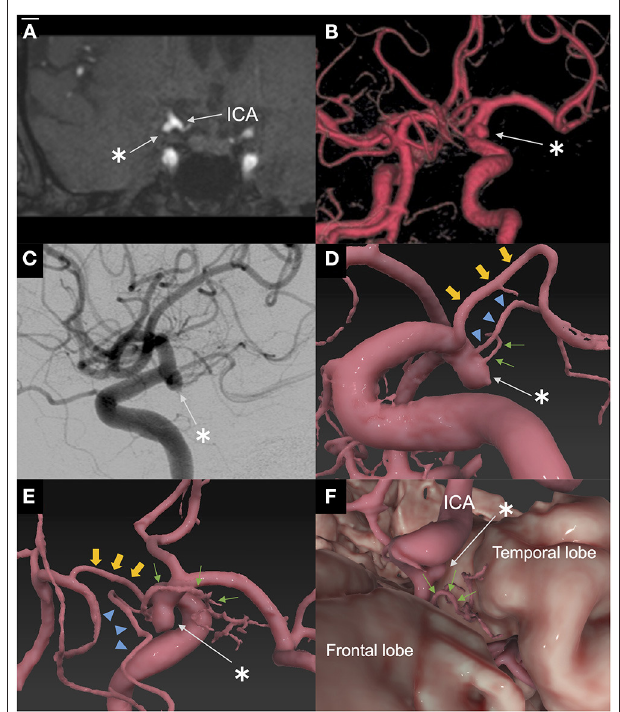
FIGURE 1 | Preoperative imaging. (A) Coronal plane of time-of-flight magnetic resonance angiography on admission. Coronal plane of time-of-flight magnetic resonance angiography showed an unruptured aneurysm of the right internal carotid artery in contact with the temporal lobe. *: aneurysm. (B) Three-dimensional time-of-flight magnetic resonance angiography on admission. Three-dimensional time-of-flight magnetic resonance angiography showed an unruptured aneurysm of the right internal carotid artery supraclinoid portion. *: aneurysm. (C) Lateral view of digital subtraction angiography of the right internal carotid artery. Lateral view of digital subtraction angiography of the right internal carotid artery showing an aneurysm associated with a duplicated middle cerebral artery and anterior choroidal artery. *: aneurysm. (D) Fusion three-dimensional computer graphics integrating MR imaging/MR angiography and three-dimensional rotational angiography. Fusion three-dimensional computer graphics showed that the duplicated middle cerebral artery and the anterior choroidal artery originated from the dome. *: aneurysm; small arrow (green): duplicated middle cerebral artery; arrowhead (blue): anterior choroidal artery; large arrowhead (yellow): posterior communicating artery. (E) Fusion three-dimensional computer graphics. Fusion three-dimensional computer graphics shows that the duplicated middle cerebral artery passed through the sylvian fissure along the M1 segment of the MCA. *: aneurysm; small arrow (green): duplicated middle cerebral artery; arrowhead (blue): anterior choroidal artery; large arrowhead (yellow): posterior communicating artery. (F) Fusion three-dimensional computer graphics. Fusion three-dimensional computer graphics showed that the duplicated middle cerebral artery perfused the anterior temporal lobe. *: aneurysm; small arrow (green): duplicated middle cerebral artery. Fusion three-dimensional computer graphics were reconstructed by GRID 1.1 software (Kompath Inc., Tokyo, Japan).